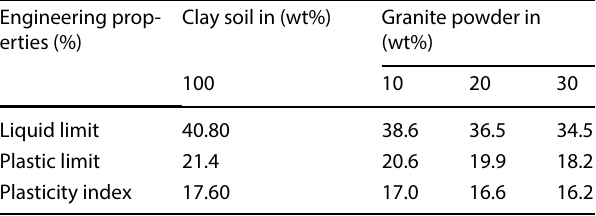
Table 3 Physical properties of the clay soil added with granite pow- der Engineering prop- erties (%)